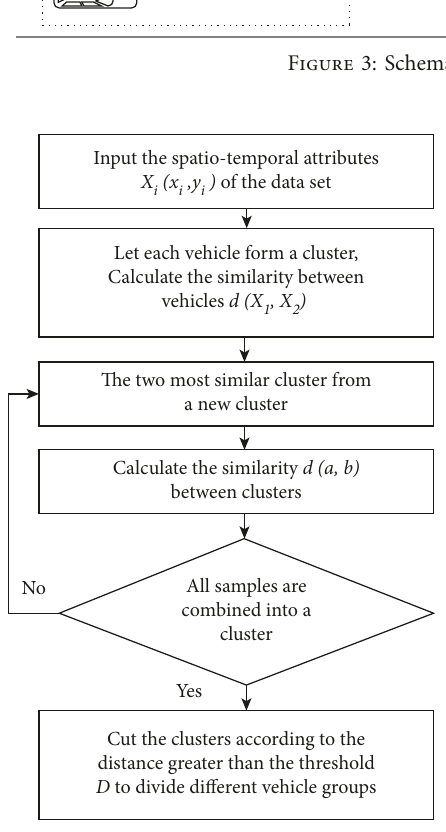
Figure 4: Vehicle group division